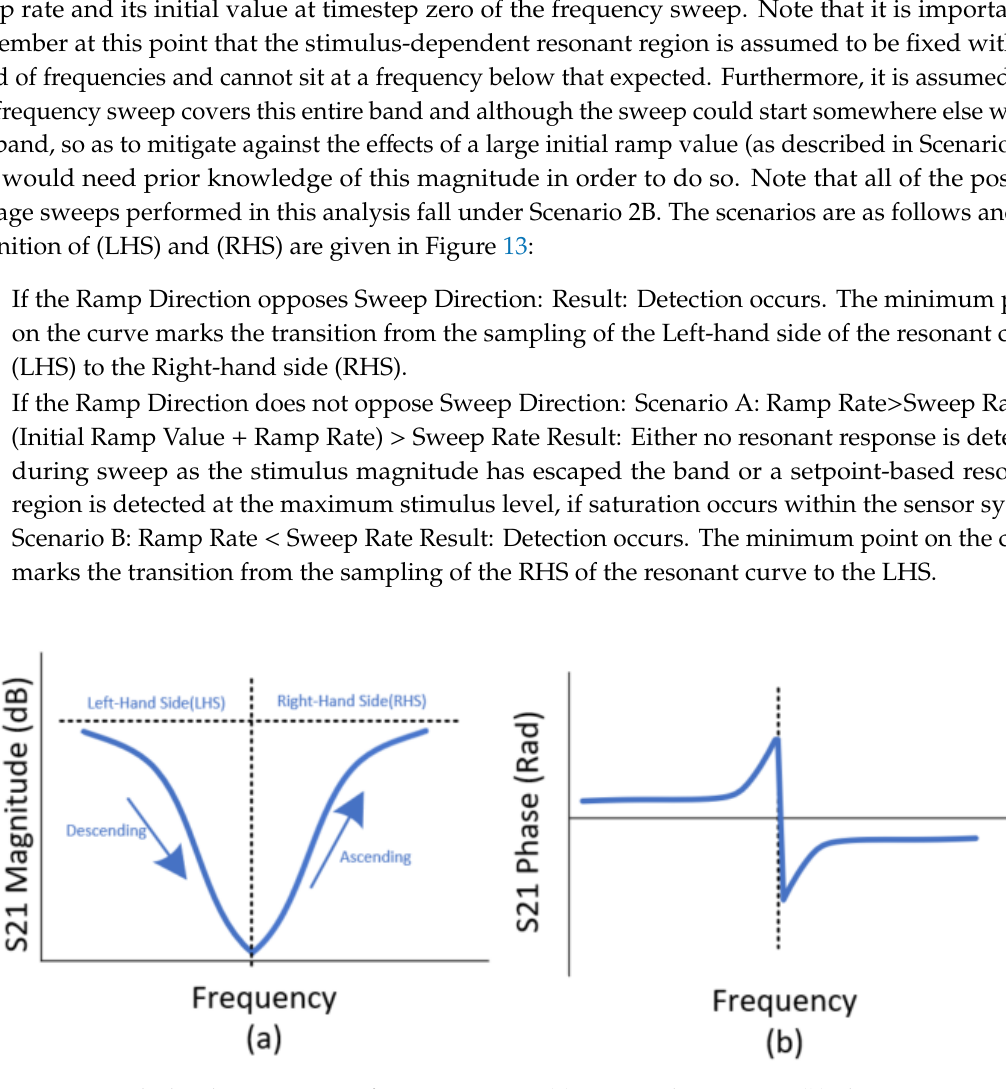
Figure 13. Idealized S21 response of resonant region; ( a ) Magnitude Response, ( b ) Phase Response.